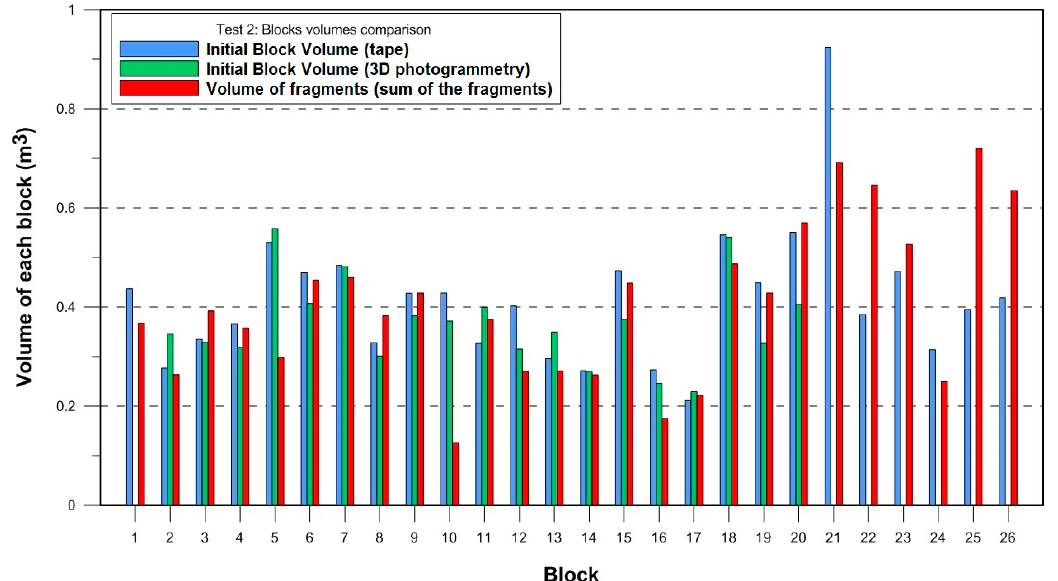
Figure 7. Initial block volume measured with a tape, initial block volume from 3D models and sum of the generated fragments’ volume, in test 2.